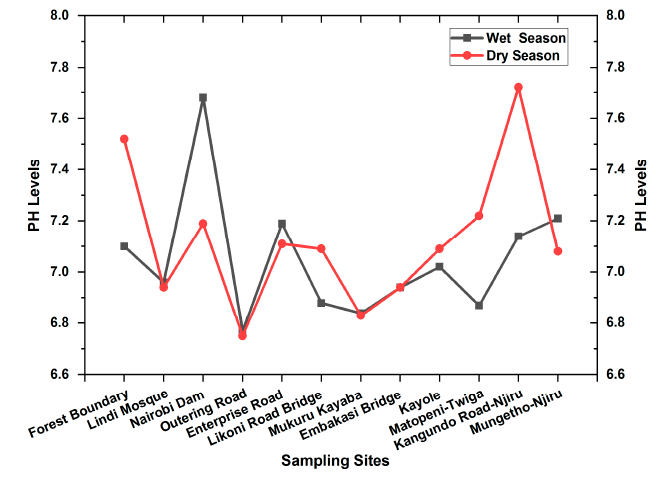
Figure 9. The pH levels of Ngong River measured between April and August 2021.